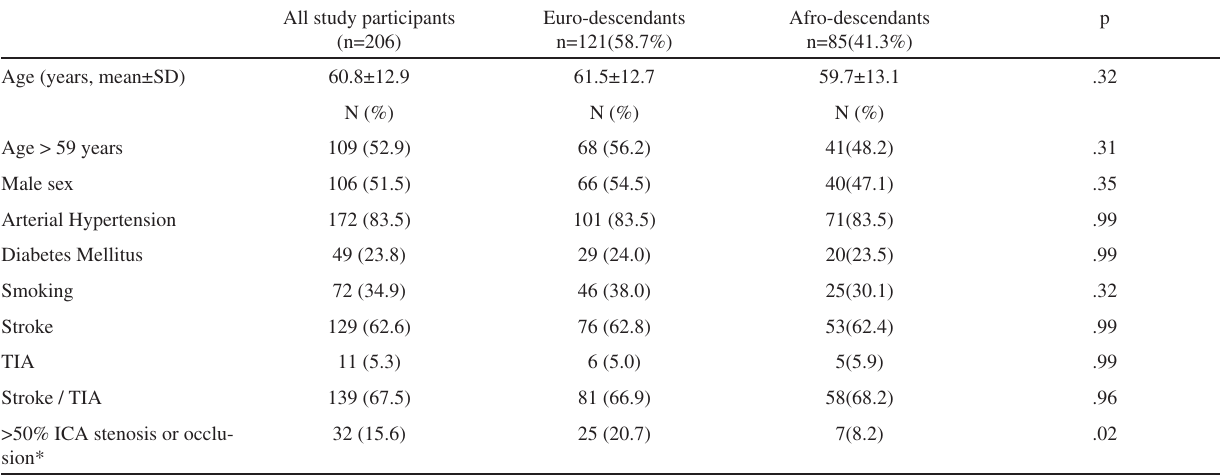
Table I - Clinical and demographic characteristics stratified by ethnic